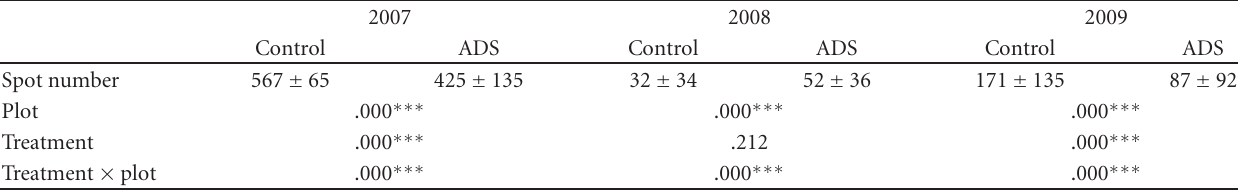
Table 2: E ff ect of anaerobically digested slurry on root-lesion nematode infested spot number on radish at Miura, Kawashima